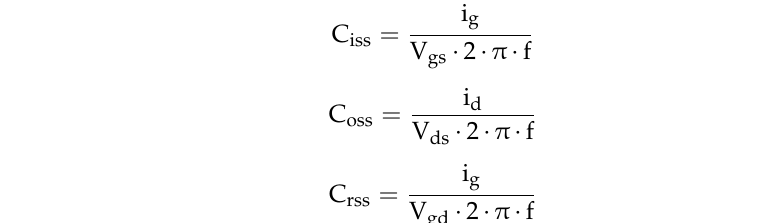
Figure 4. C rss measurement fixture.